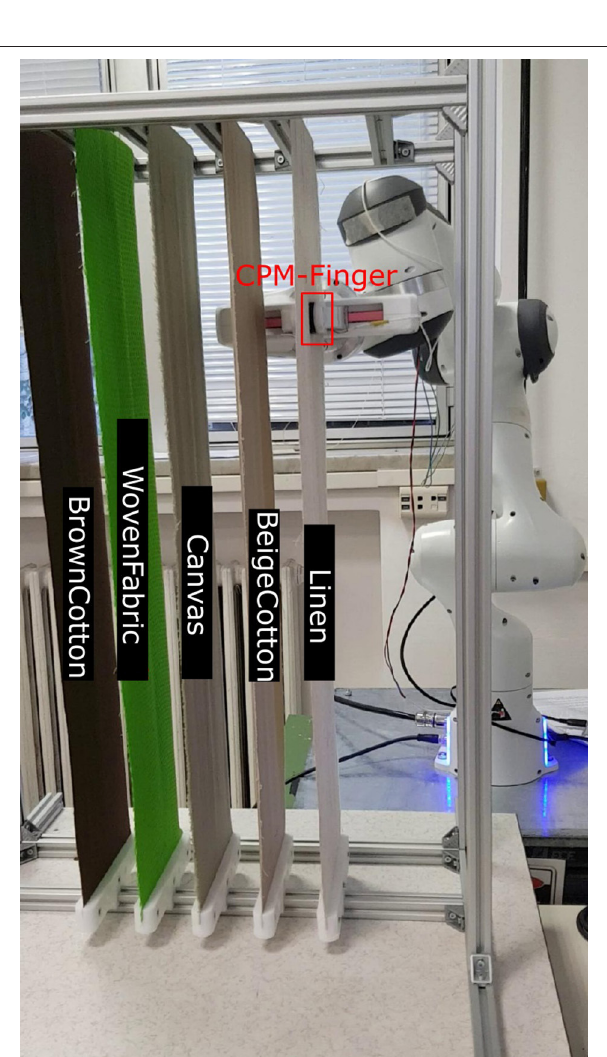
FIGURE 5 | Illustration of the experimental setup. The original rubber fingertip of the gripper is replaced with a CPM-finger sensor. Five fabrics are fixed on an aluminum rack at one time.